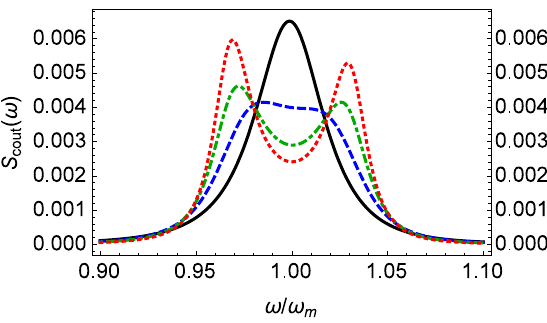
Figure 6. The spectrum S cout ( ω ) of the output field versus the normalized frequency ω / ω m for different reflection coefficients r = 0 (black solid), 0.2 (blue dashed), 0.3 (green dot-dashed), 0.35 (red